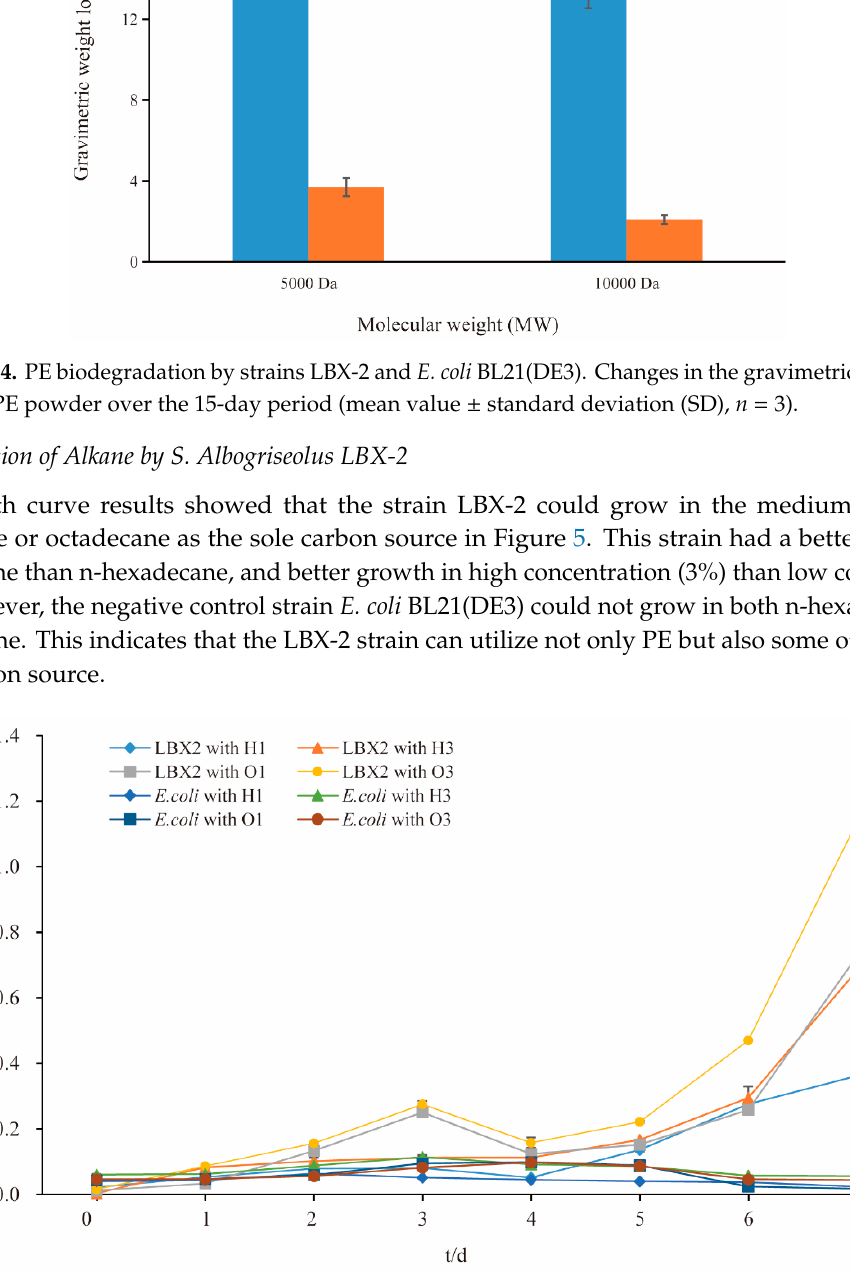
Figure 5. Growth curves of S. albogriseolus LBX-2 and E. coli BL21(DE3) in the medium containing n-hexadecane or n-octadecane. H1: the final concentration of n-hexadecane was 1%, H3: the final concentration of n-hexadecane was 3%, O1: the final concentration of n-octadecane was 1%, O3: the final concentration of n-octadecane was 1%.